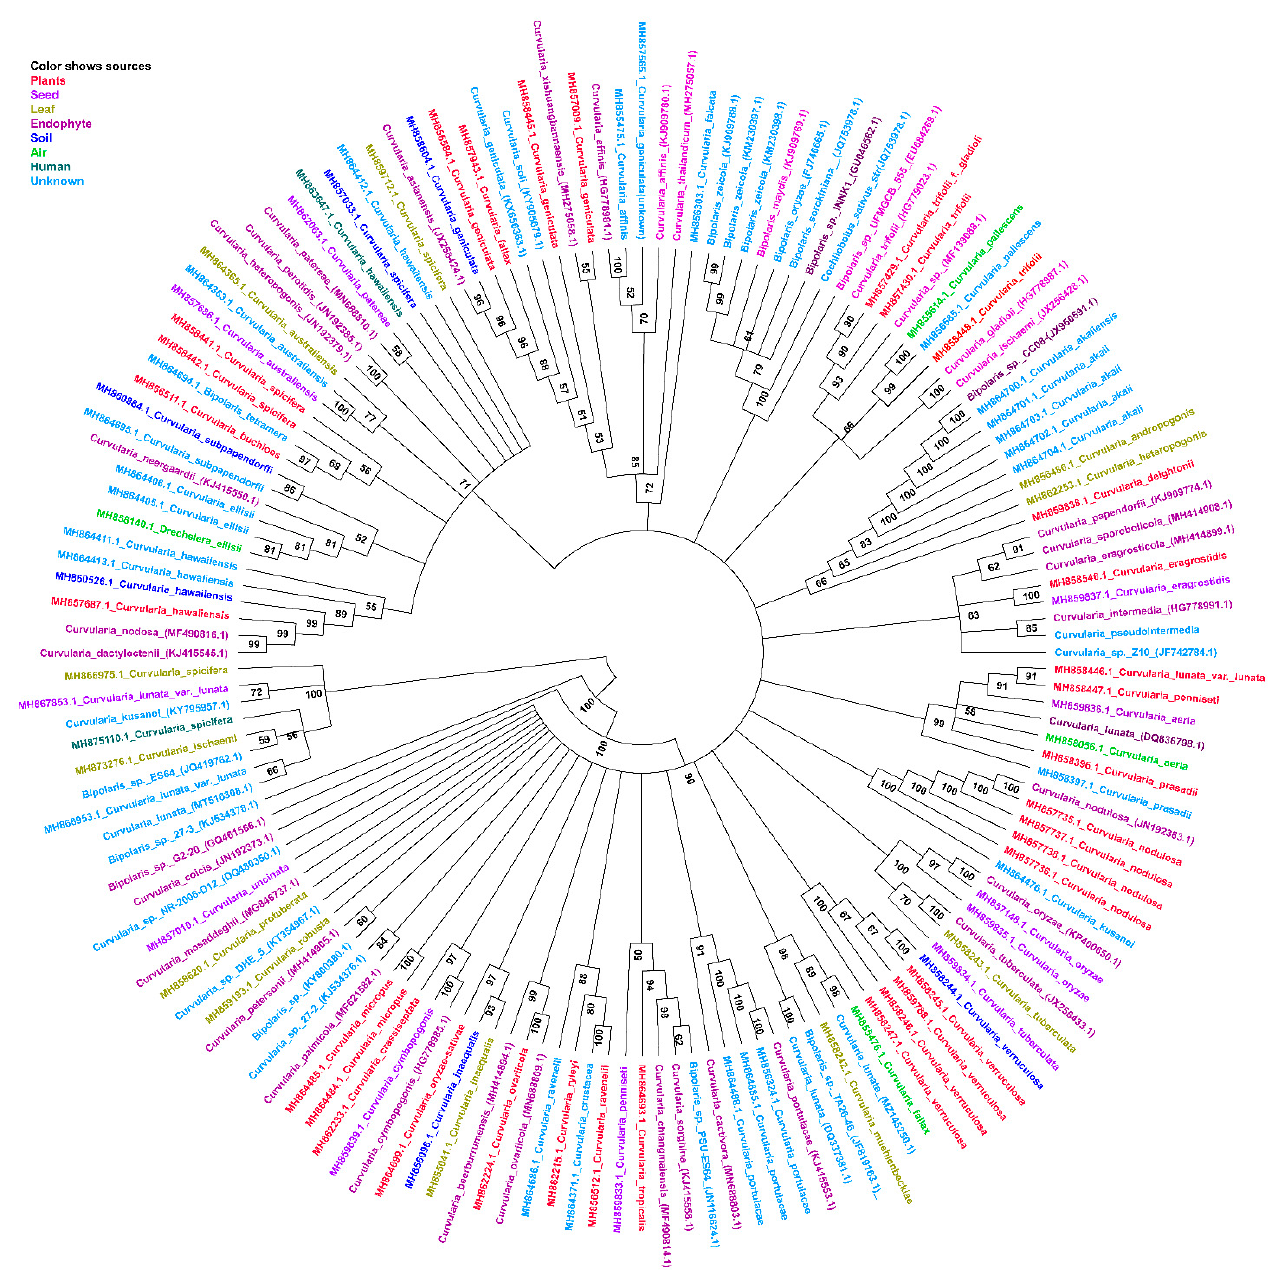
Figure 1. Phylogenetic analysis of the Curvularia and Bipolaris species isolated from different sources based on ITS genes. The maximum likelihood (ML) method was used to infer the phylogenetic analysis. The number above the branches is the bootstrap value for the ML.